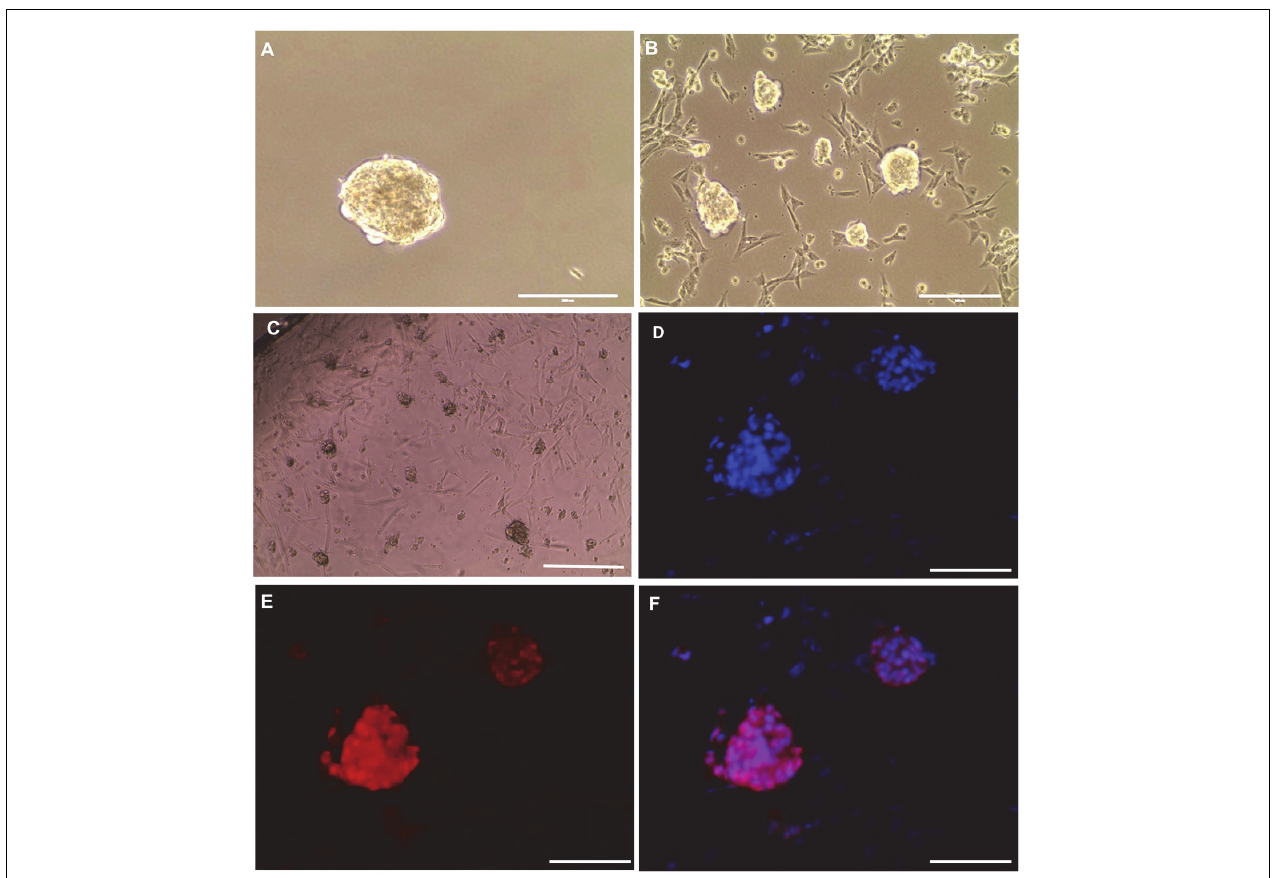
FIGURE 6 | SSCLCs maintain their SSC-like identity after vitrification and long-term propagation (A) , Frozen cluster. (B) , Culture for 35 days of growth post warming. (C) Bright-field image of new clusters (passage 5), scale bar: 400 µ m. (D–F) whole mount immunostaining of SSCLCs at passage 5, D , DAPI; E , VASA; F , Merge. Scale bar: 100 µ